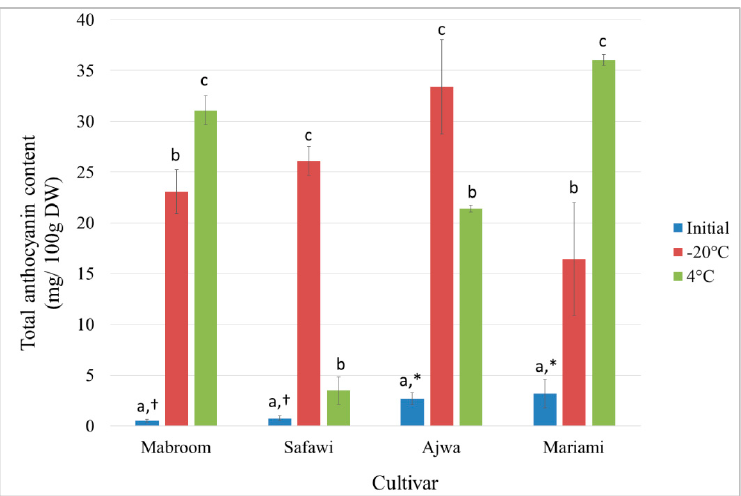
Figure 3. Effect of storage temperature ( − 20 °C and 4 °C) on the stability of anthocyanin content in different P. dactylifera cultivars, after 5 weeks. Values are the mean ± standard error of a minimum of three samples. The means with different letters and/or symbols differed significantly at p < 0.05 (subject to different cultivars).